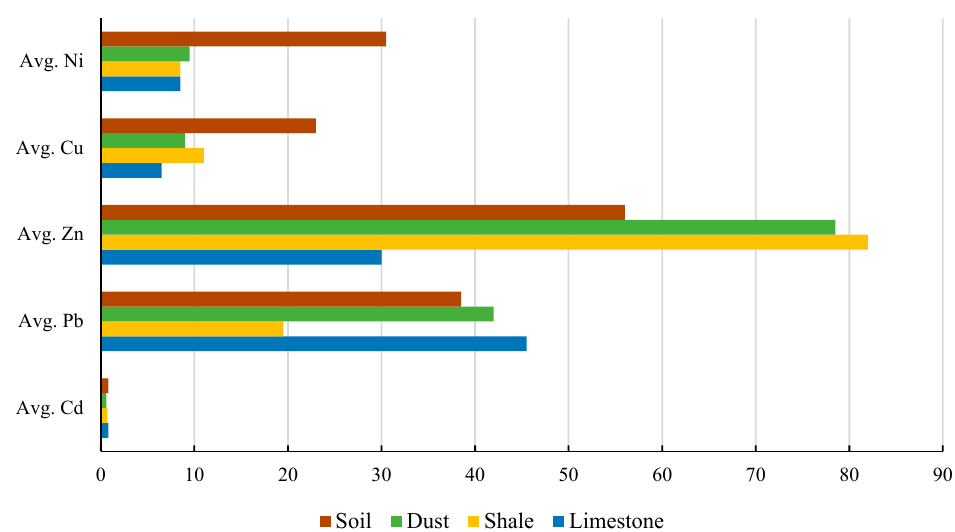
Figure 6. Average levels of heavy metals around Sagamu cement area (in ppm). The study further proposed that the voluminous metallic concentration in the soil and soot emanated from unprocessed inputs adopted by cement makers and resultant factory emissions. A study performed by A. N. (2012) [64] revealed that 30,435 disease cases were linked to air pollution in Rivers State, and 61 of its patients were reported dead. Prevalent diseases associated with the cases include: cerebrospinal meningitis (CSM),